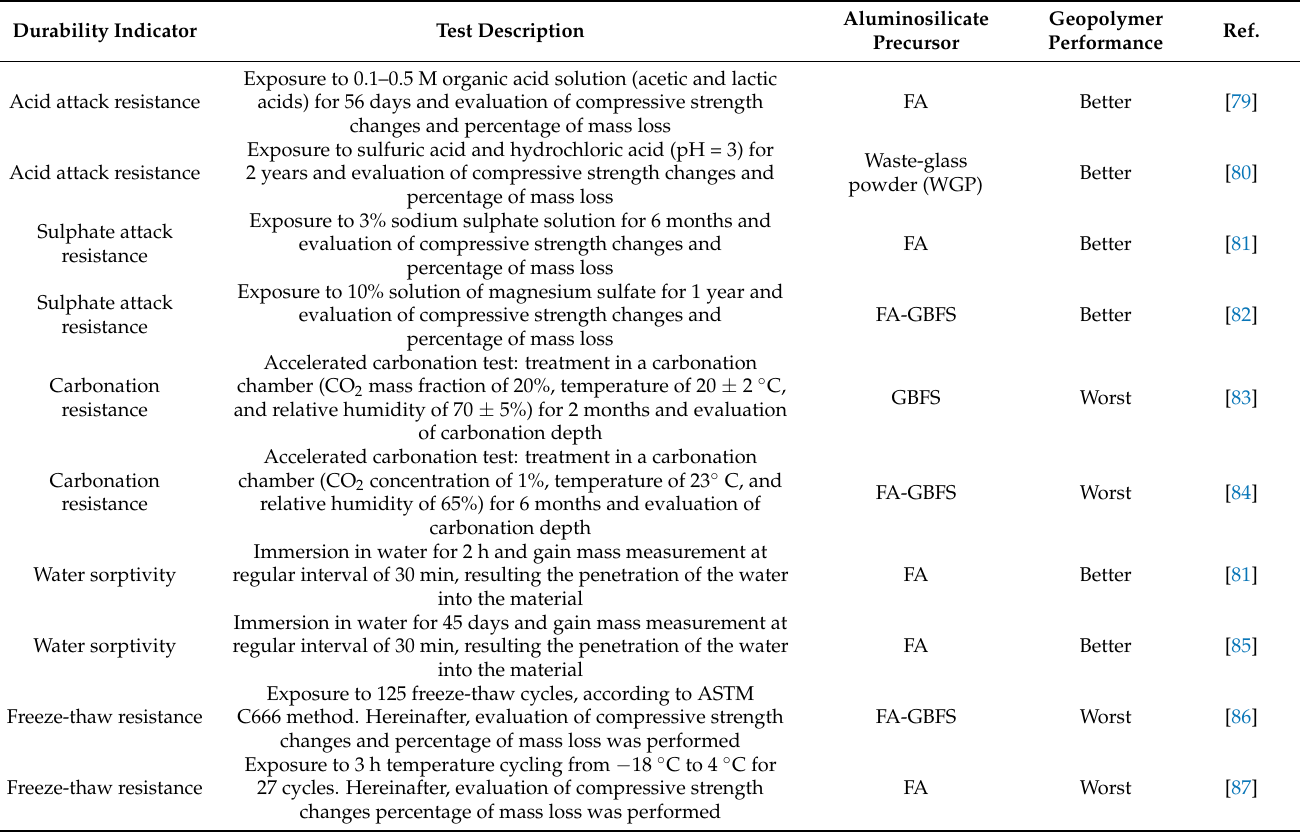
Table 5. Durability performance of geopolymer mixes compared to Portland